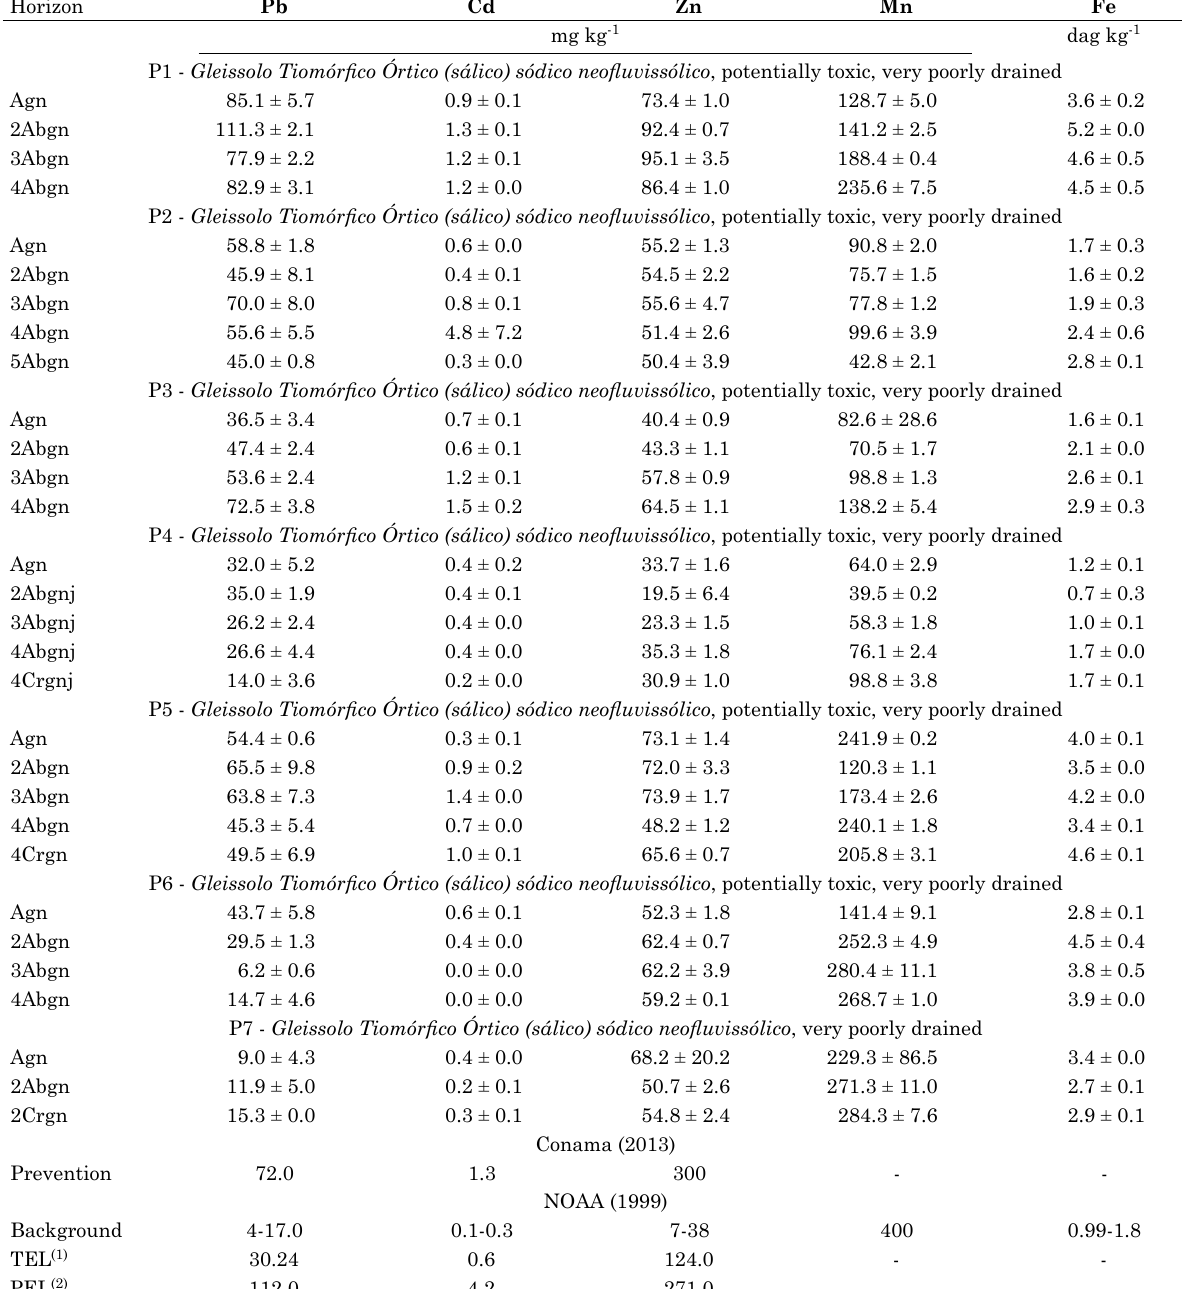
Table 4. Heavy metal concentrations (mean ± standard deviation) in mangrove pedons from the Subaé river basin, Bahia, Brazil and reference values for metals